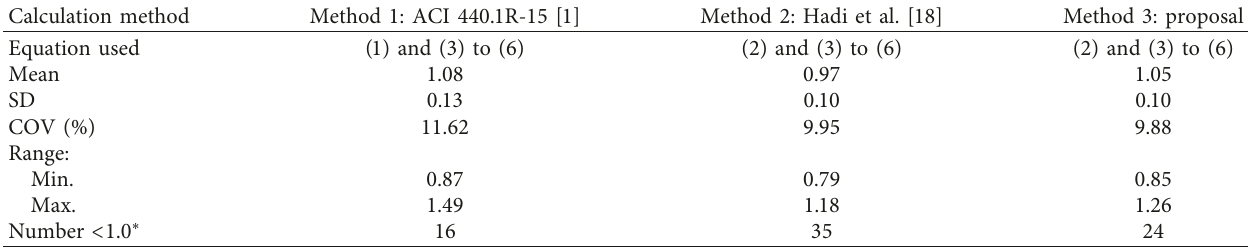
Table 4: Comparison of P Exp. / P Theo by the three calculation methods for 61 concrete columns reinforced with FRP bars.